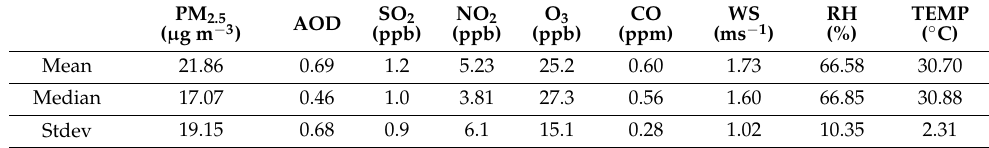
Table 1. Statistical values for the measured parameters in all air-pollution monitoring sites.